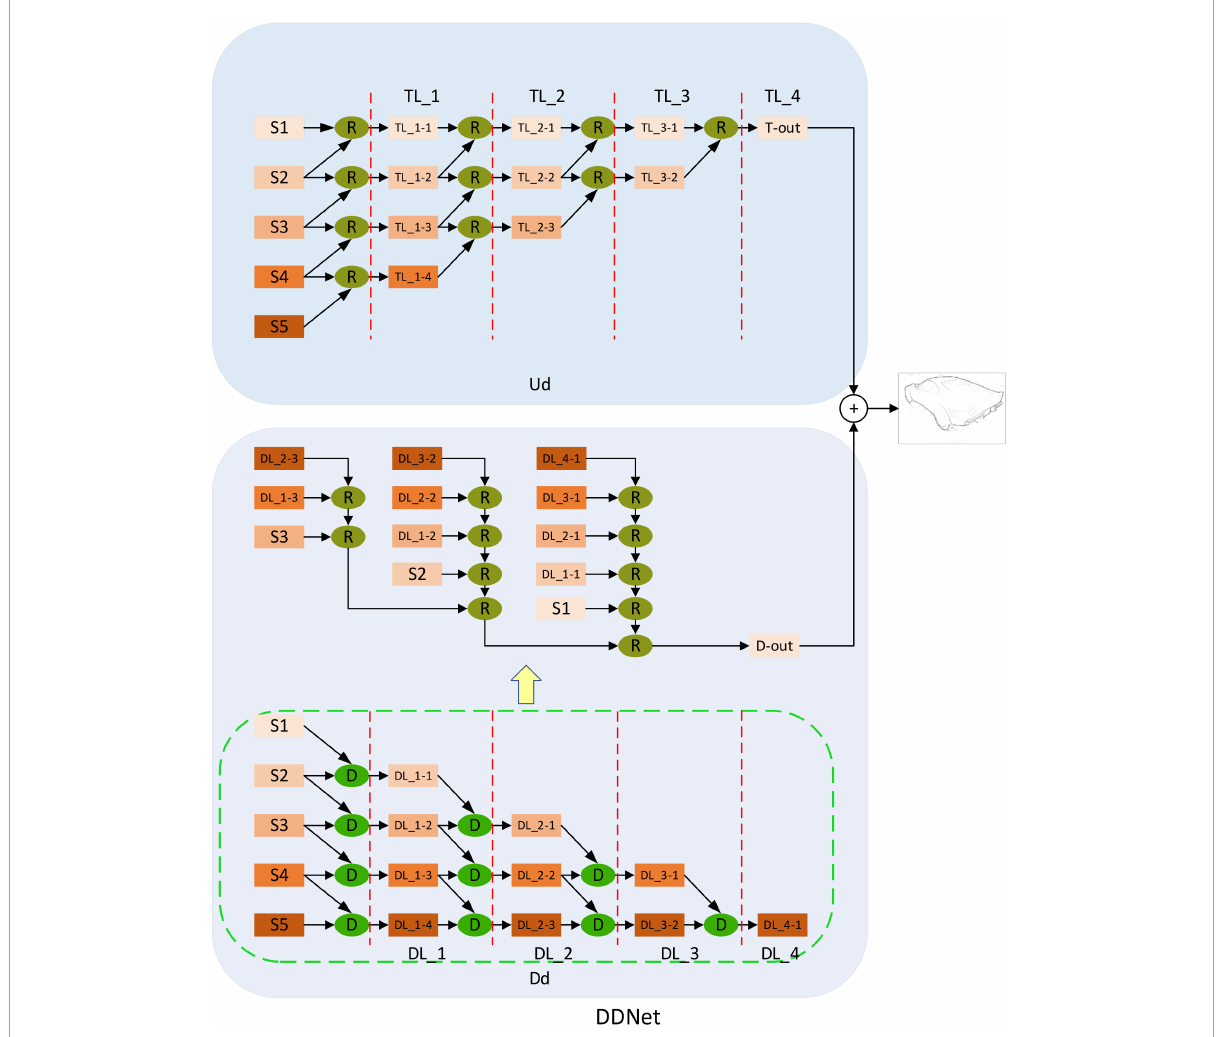
FIGURE5 Double decoding network structure diagram. Up-sampling decoding (Ud) and down-sampling decoding (Dd) receive output from the modulation coding network. S1, S2, S3, S4, and S5 represent the five different outputs of the modulation coding network. Among them, Ud utilizes the “R” module to realize top-down feature fusion, while Dd utilizes the “D” module to realize bottom-up feature fusion. Finally, the result fusion of the two realizes full extraction and fusion of context information. TL_i (i = 1,2,3,4) represents the different stages of top-to-bottom feature fusion. The TL_1 stage takes five different outputs of the modulation coding network as inputs and obtains four different outputs (TL_1-TL_1-4) after processing by the “R” module. Then these four different outputs are used as the input of TL_2 in the next stage, and three different outputs (TL_2-1-TL_2-3) are obtained. This is processed step by step to TL_4 to obtain the output of Ud. The same DL_i (i = 1,2,3,4) symbol is similar to TL_i. It represents the different stages of top-down feature fusion. Five different outputs of the modulated coding network are taken as inputs and processed step by step by the “D” module until DL_4. In addition, the orange rectangles in different shades represent outputs of different resolutions. We detail the structure of “D” and “R” in Figure 6